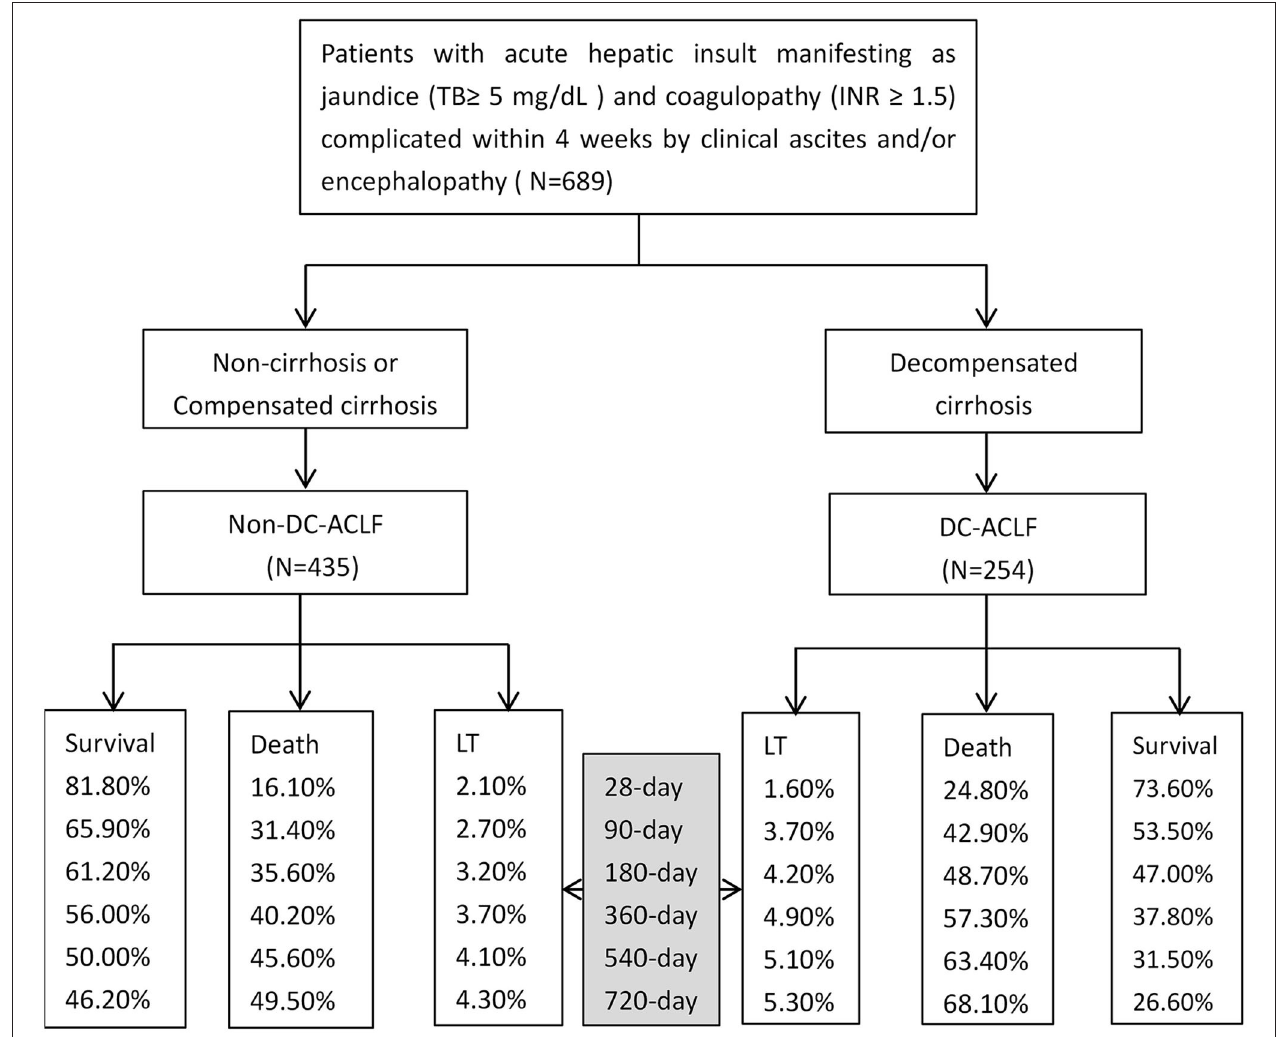
FIGURE 1 | Acute-on-chronic liver failure (ACLF) with different underlying chronic liver diseases and associated outcomes since